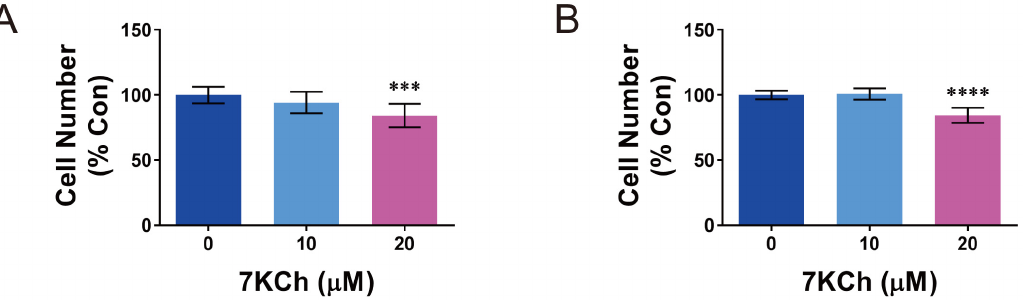
Figure 1. 7KCh inhibits the growth of cardiomyocytes. HL-1 ( A ) or AC16 ( B ) cells were seeded at a cell density of 5 × 10 4 per well of a 24 well culture plate, and after attachment, they were treated with the indicated concentrations of 7KCh for 24 h. Cells were stained with Hoechst 33342. The cell number was quantified using IN Cell Analyzer 1000 and is expressed as the percentage relative to the untreated cells. Data are mean ± SD of six experiments. *** p < 0.005, **** p < 0.001 vs. the 0 μ M 7KCh treatment group.